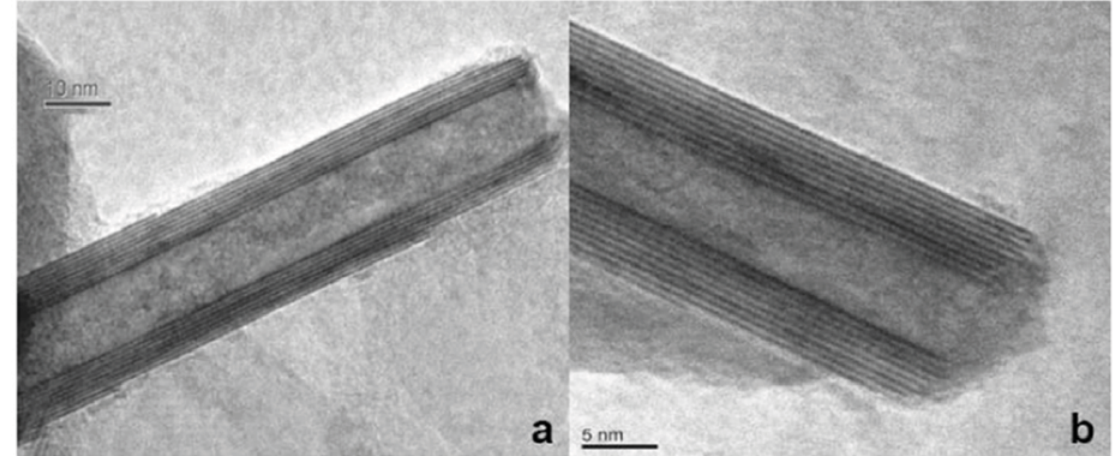
Figure 8. TEM micrographs of WS